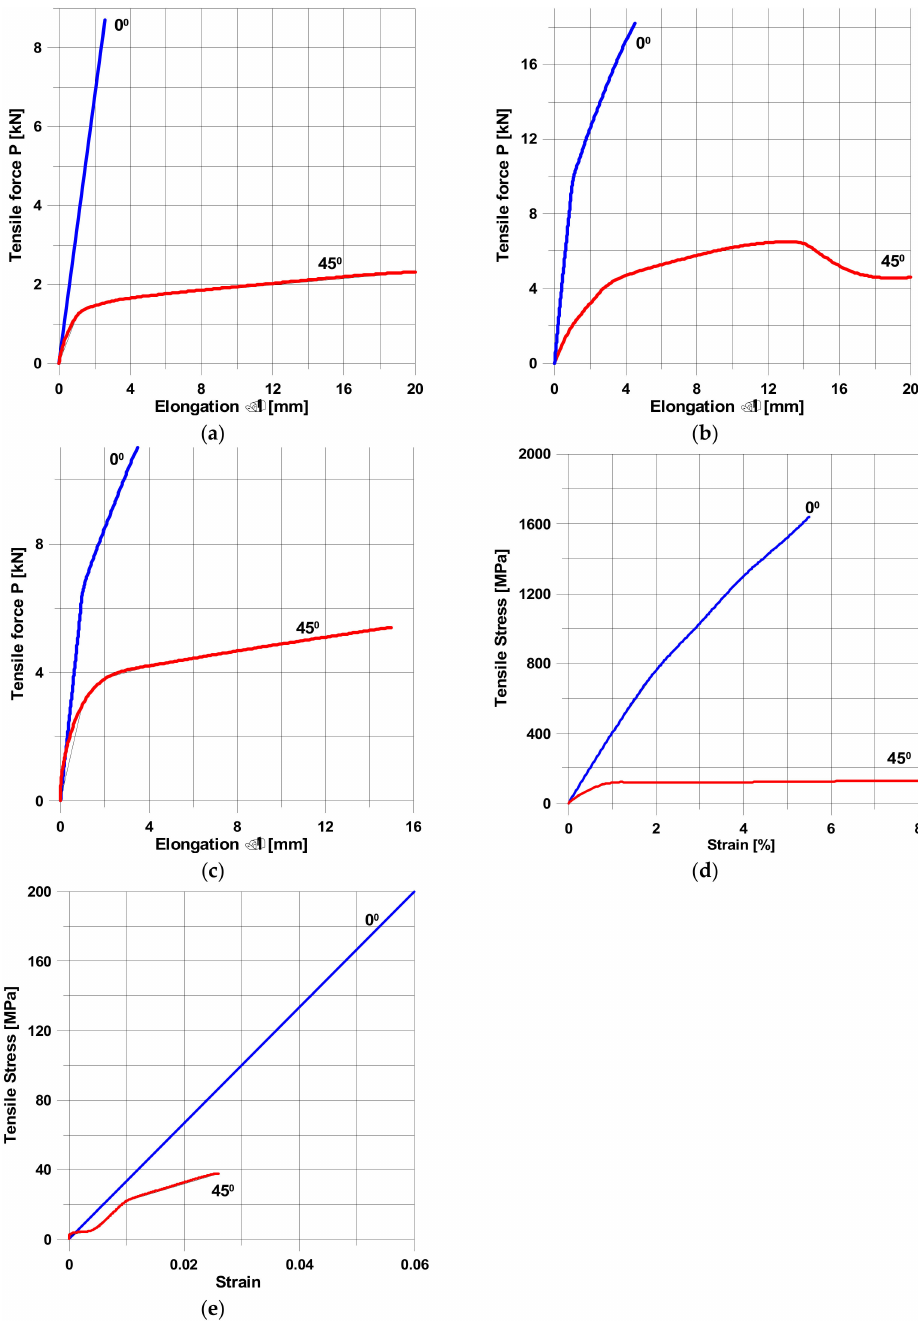
Figure 1. Stress / strain diagram of composites showing experimental responses. ( a ) plain woven roving—aramid / epoxy resin (Muc [13]). ( b ) plain woven roving—carbon / epoxy resin (Muc [13]). ( c ) plain woven roving—glass / epoxy resin (Muc [13]). ( c ) plain woven roving—glass / epoxy resin (Muc [13]). ( d ) unidirectional—glass / epoxy resin (Muc et al. [14]). ( e ) unidirectional—glass / vinyl ester resin (the pultrusion method—Muc et al.